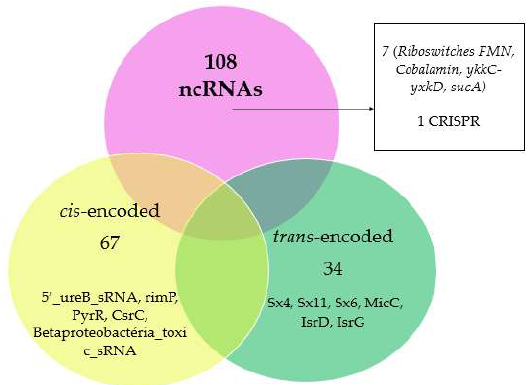
Figure 1. Examples of the cis -encoded 5 ′ _ureB_sRNA, rimP, PyrR, CsrC, Betaproteobacteria_toxic_sRNA, riboswitch, FMN, cobalamin, ykkC-yxkD, sucA; and the trans -encoded sX4, sX11, sX6, MicC, IsrK, IsrD, IsrG. The CRISPR RNA region predicted the H. seropedicae in the SmR1 genome. Table 1. ncRNAs predicted for bacteria of the genus Herbaspirillum and different from those already known in H. seropedicae SmR1. The Infernal (version 1.1.1) computational tool was used.